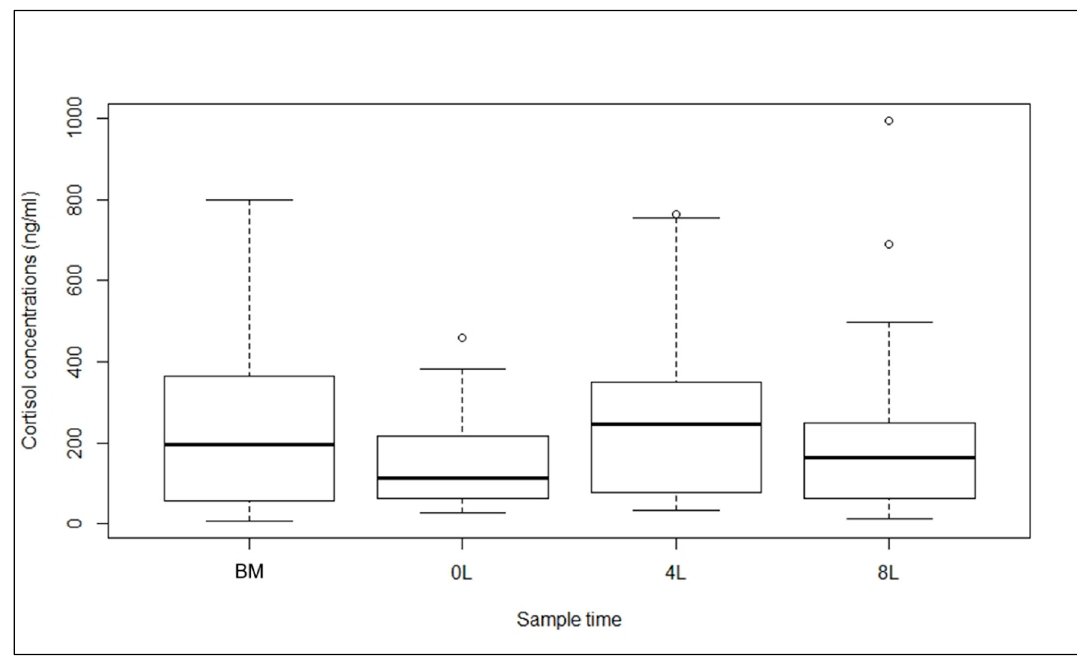
Figure 1. Cortisol concentrations in females of the domestic cat at different sampling points: BM—before mating, 0L—after parturition (0 weeks of lactation), 4L—4 weeks of lactation, and 8L—8 weeks of lactation. Plotted are the median (horizontal line in the box), lower and upper quartiles (horizontal box boundaries), and minimum and maximum values (whiskers); dots indicate outliers.